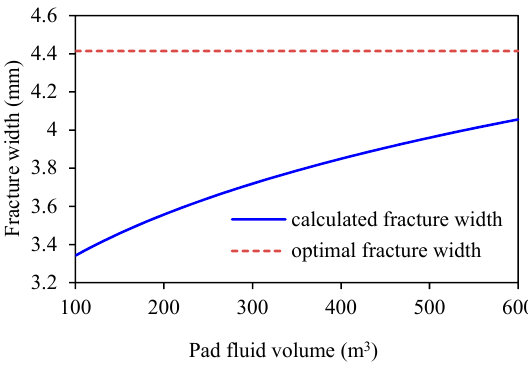
Figure 5. Curves of propped fracture width vs. pad fluid volume for the original design.